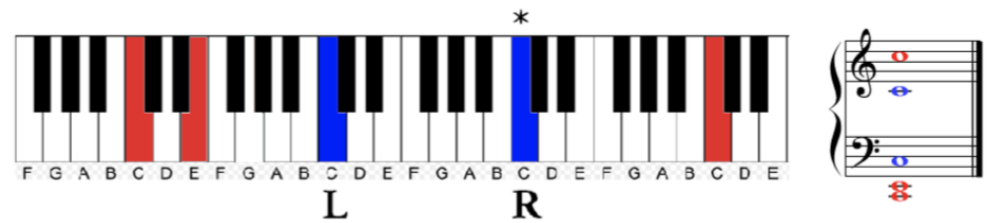
Figure 4. Red keys indicate the keys played by BRAAHMS and the blue keys indicate those played by the user [20].